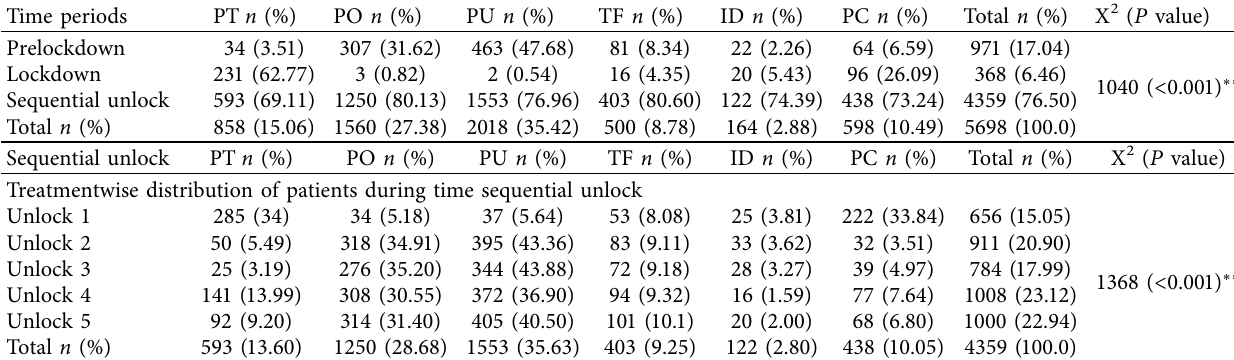
Table 3: Treatmentwise distribution of patients during various time